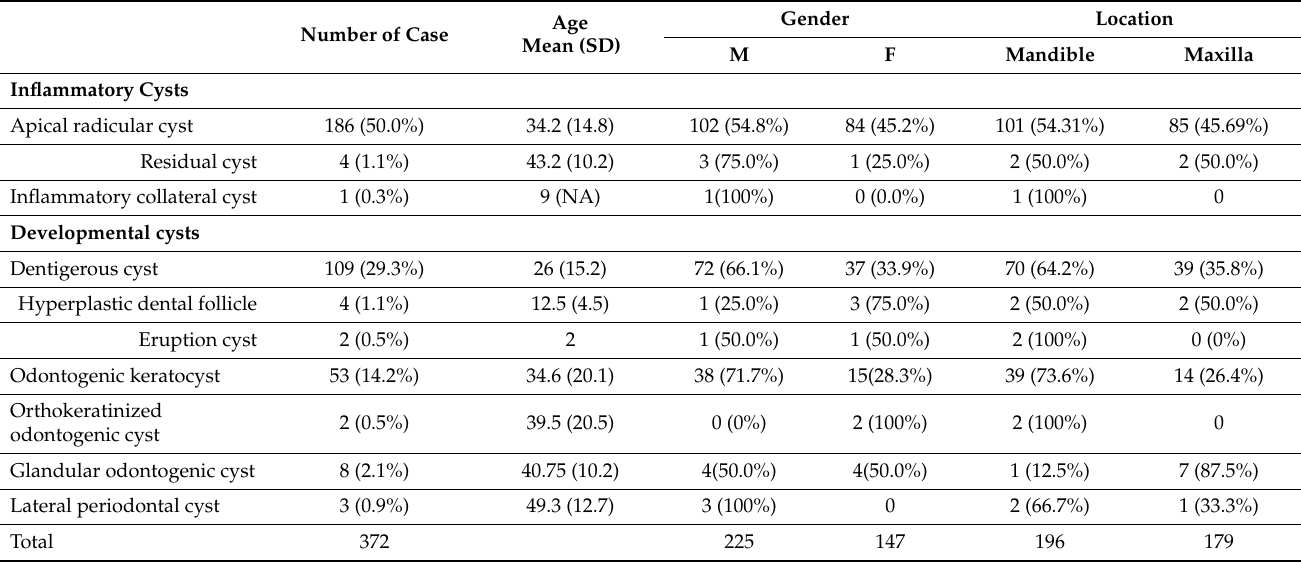
Table 4. Summary of the clinicopathological features of each odontogenic cyst.